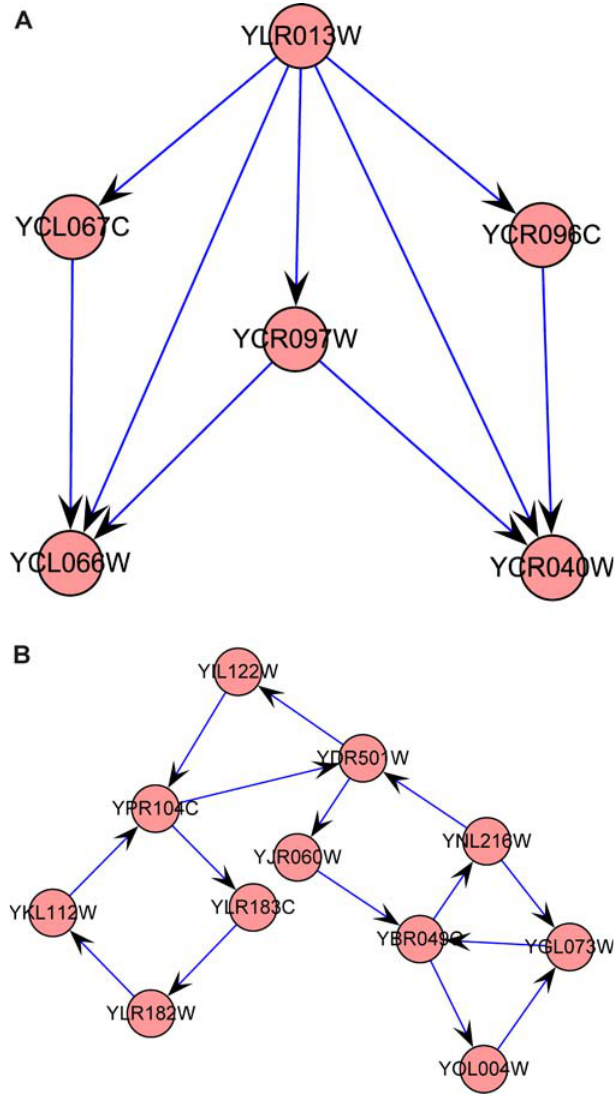
Figure 3. Two Examples of Yeast THubs with Significantly Preferred Regulatory Subgraph Patterns (A) The THub YLR013W (GAT3) significantly preferred FFLs in the cell cycle sub-network. (B) The THub YBR049C (Reb1) preferred FBLs in the static network. DOI: